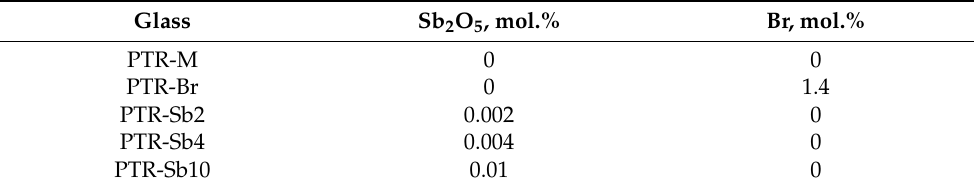
Figure 2. Photo of the PTR-M glass sample ( left ) after Na + –Ag + IE and heat treatment at 500 °C for 3 h (the resulting surface film was partially removed) and of BK-7 glass ion-exchanged and heat-treated at 600 °C for 3 h ( right ). Table 2. Batch concentration of additives in the studied PTR glass samples.